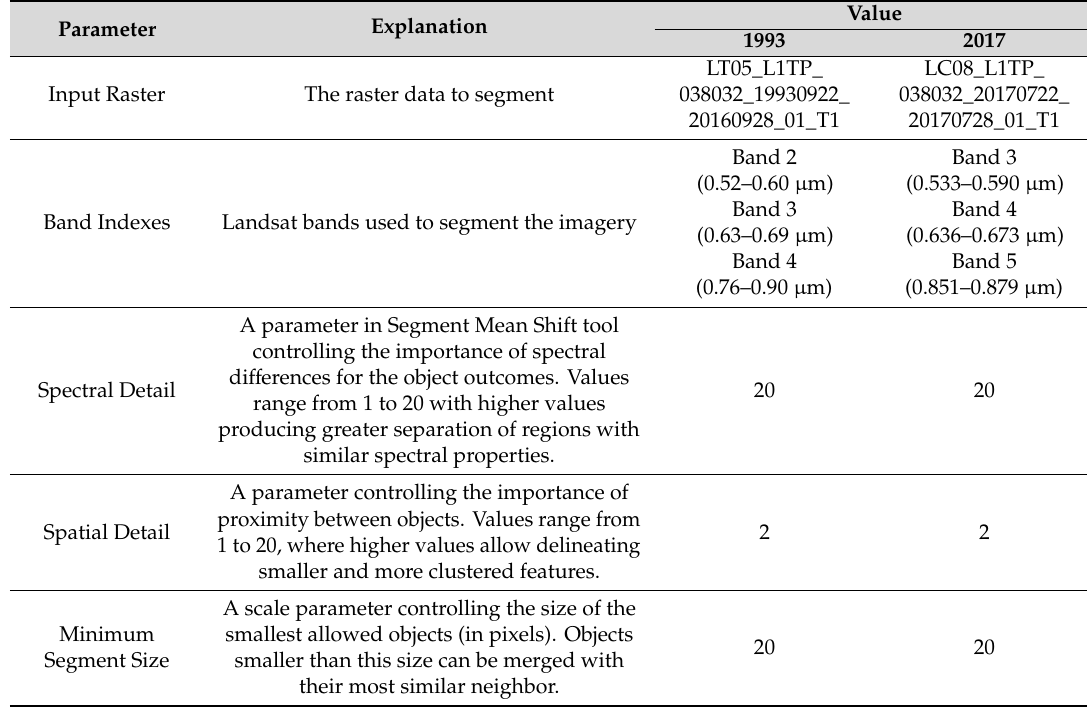
Table A1. Main parameters of the segmentation process as the first stage of OBIA workflow.